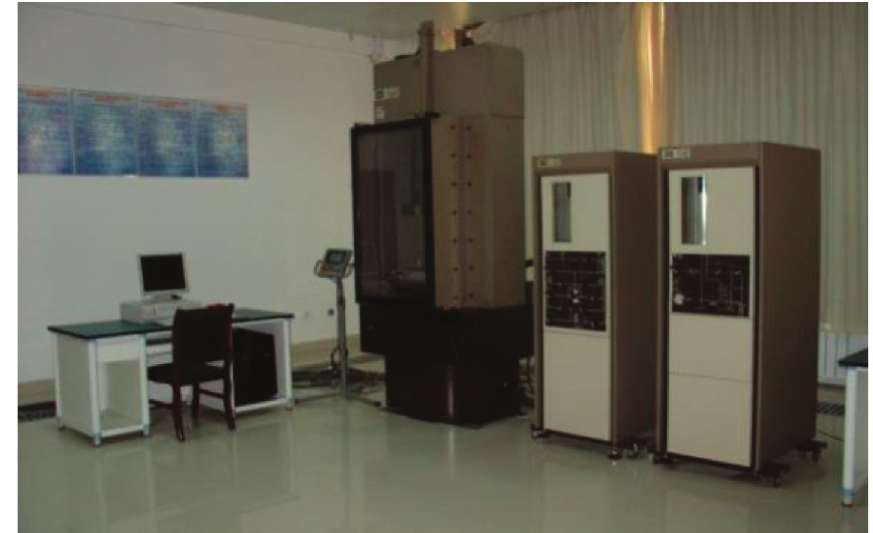
Figure 2: MTS815.03 rock mechanics test